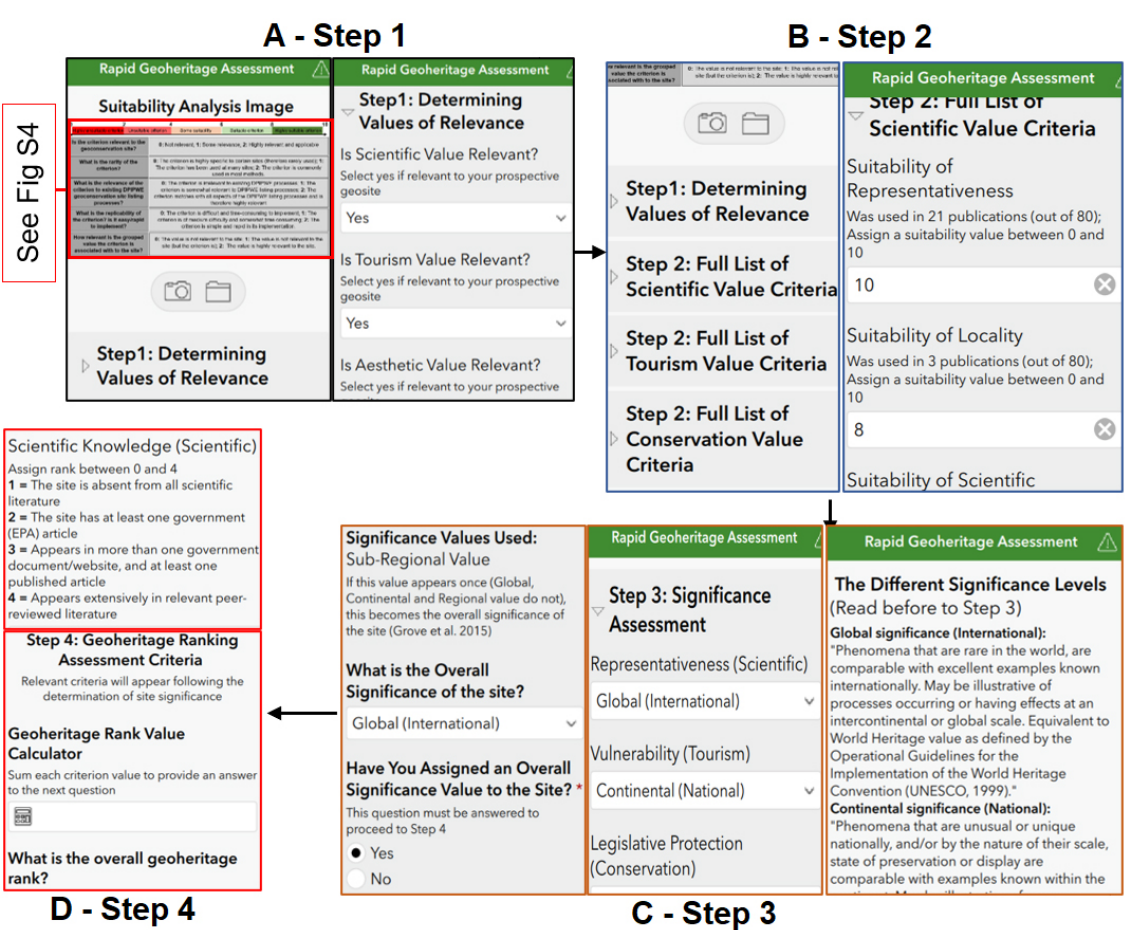
Figure 2. The four steps established for a rapid geoheritage assessment in ArcGIS Survey123. Upon opening Survey123 on a mobile device the user is presented with the Suitability Analysis Image to determine the suitability of criteria. A) The appropri- ate values of relevance for the site were determined. B) Criteria within each selected value (Step 1 – Geoheritage Values) were ranked from 0 to 10 based on the suitability analysis image. C) All criteria with a rank of nine or higher were selected for the significance assessment in Step 3. Each criterion was assigned a significance value and then an overall significance value was subsequently determined. D) Criteria were ranked from 0 to 4 based and then an overall geoheritage rank value was